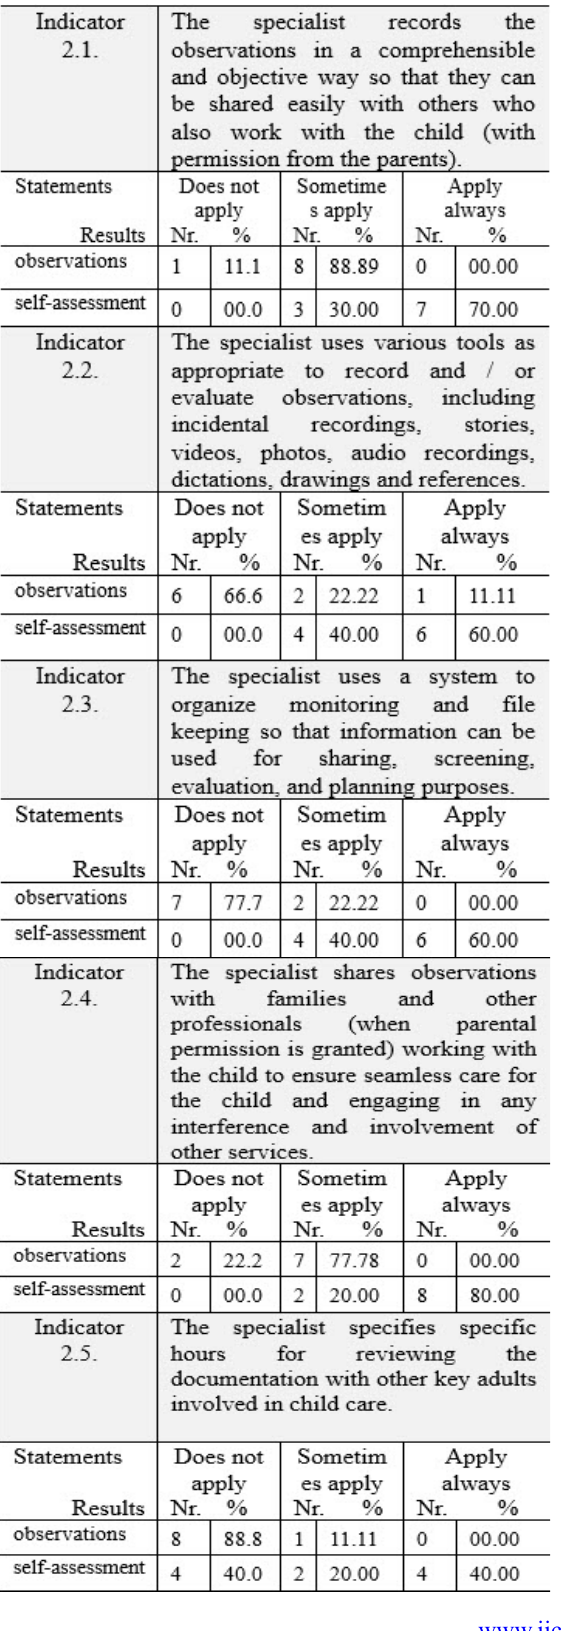
Table 24. Principle 3: The joint discus - Table 25. Principle 4: Long-term and sion of children’s observations and the docu - short-term planning is based on individual mentation of their learning and socialization children’s strengths and experiences motivates the review of profes - sional practices and their future improvement.